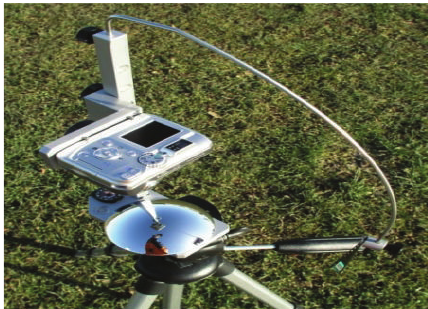
Figure 3: A typical horizon catcher device (photo courtesy of HORIcather).